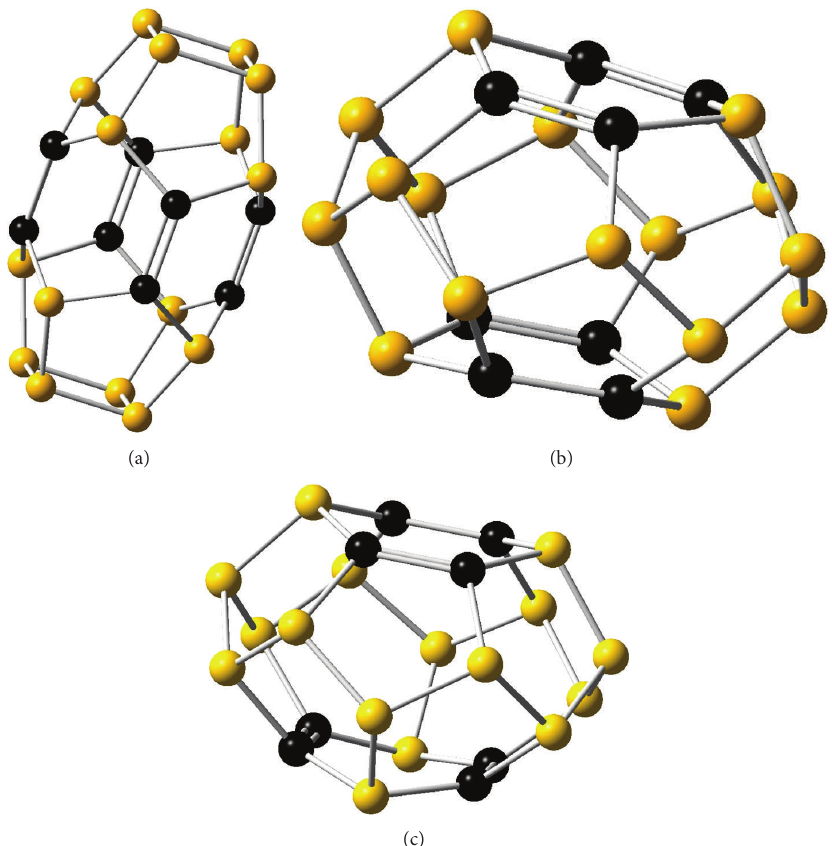
Figure 4: Isomers of N 16 C 8 : (a) isomer S, (b) isomer H1, and (c) isomer H2. Carbon atoms are shown in black, and nitrogen atoms are shown in